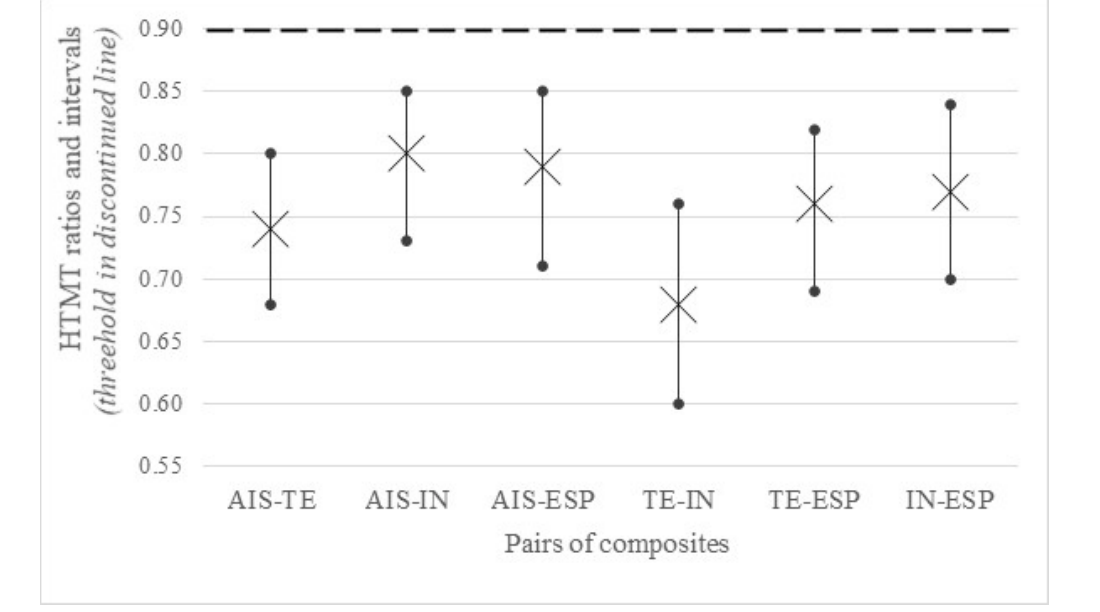
Figure 5. Convergent validity.